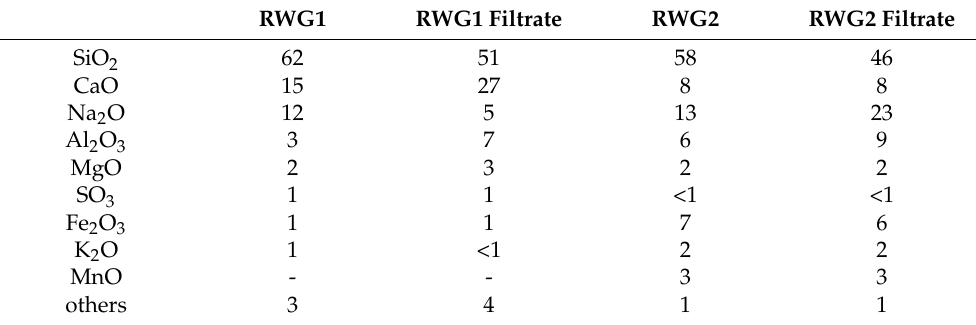
Table 1. The mineralogical composition was assessed using X-ray diffraction (XRD, Bruker D2 Phaser, Bruker, Billerica, MA, USA) in a 2 θ range of 10–70 ◦ . The produced activating solutions were analyzed with respect to their solid content and SiO 2 /Na 2 O molar ratio by